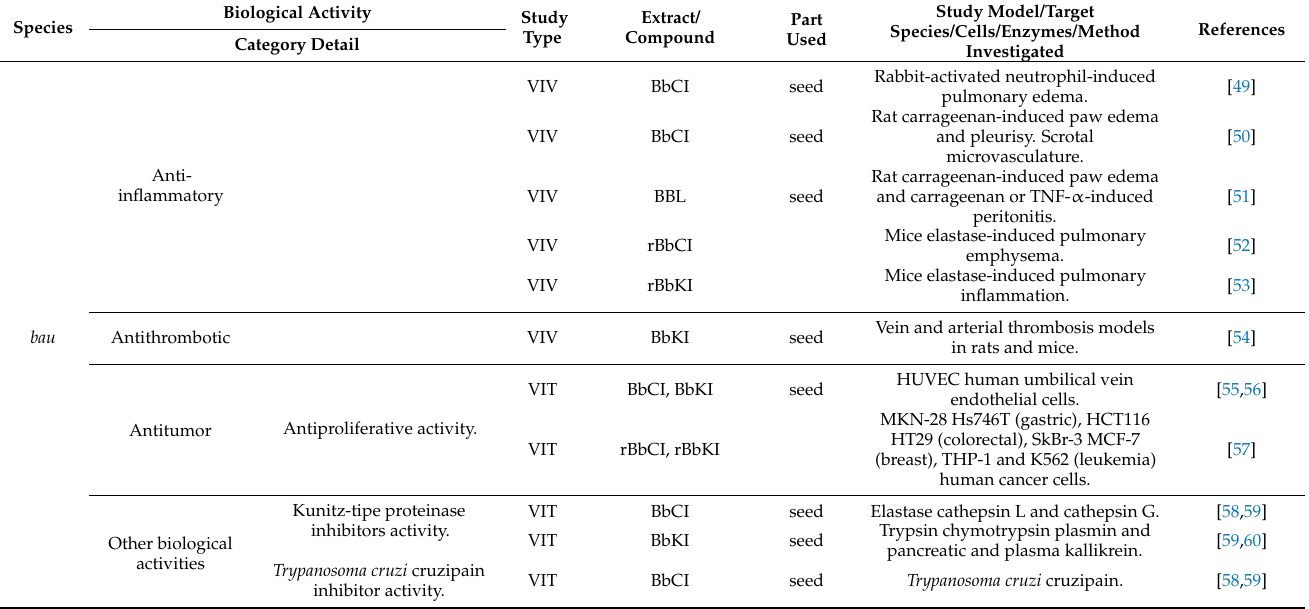
Table 3. Main antidiabetic properties and related activities of Bauhinia forficata and B. holophylla . Table 2. Biological activity of austral South American Bauhinia . The activities are grouped into Model animals were Wistar rats, Swiss mice or New Zealand rabbits, except where indicated. eight categories (see Figure 2 and Sections 3.1–3.8 in the text). bau—bauhinioides ; che—cheilantha